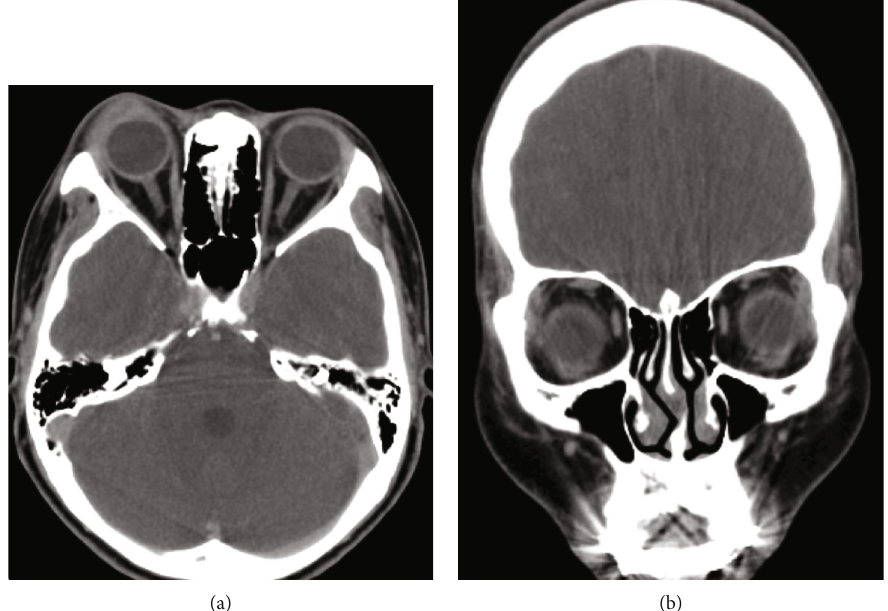
Figure 2: (a) Computed tomography (CT) axial view. (b) Computed tomography (CT) coronal view. (a, b) An in fi ltrative mass at the right superolateral orbital involving the lacrimal gland and upper eyelid.